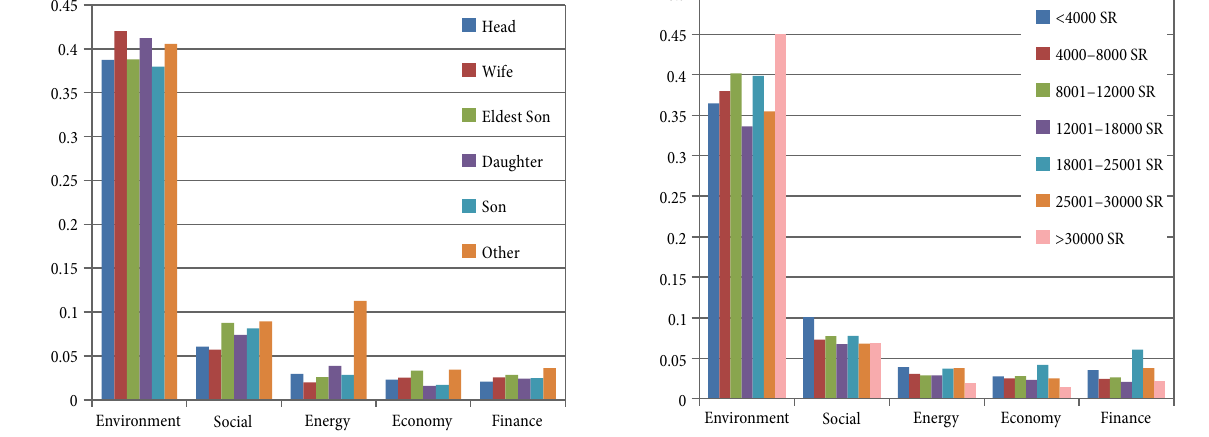
Fig. 3. Composite Index of level of sustainability from family perspective